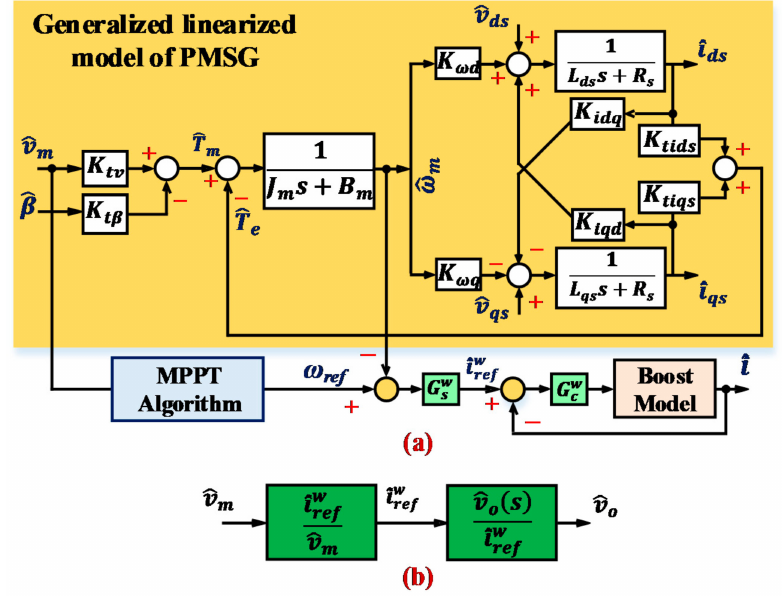
Figure 5. ( a ) Small signal block diagram of a wind turbine, PMSG and boost converter with speed control; ( b ) simplified block